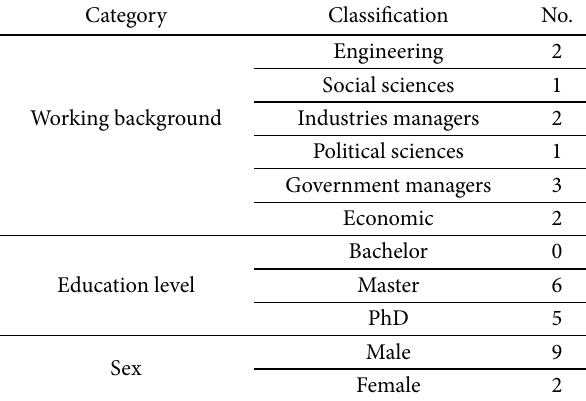
Table 2. Background information of experts